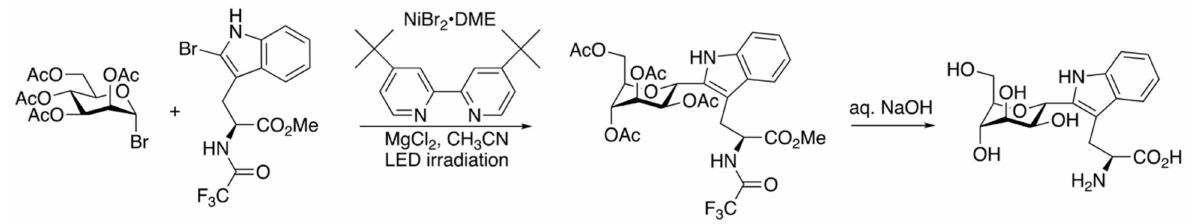
Scheme 5. Photoreductive cross-coupling C -Man-Trp